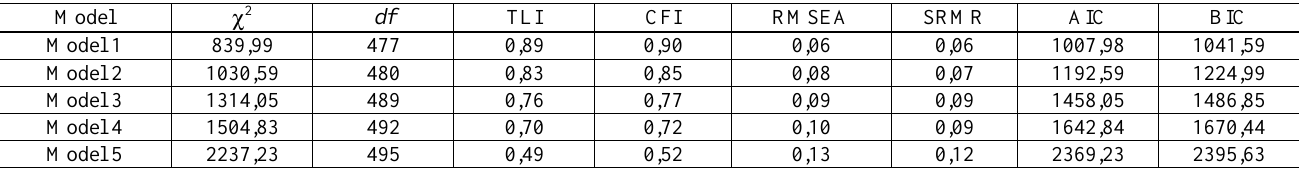
Table 4: Fit statistics of competing measurement models